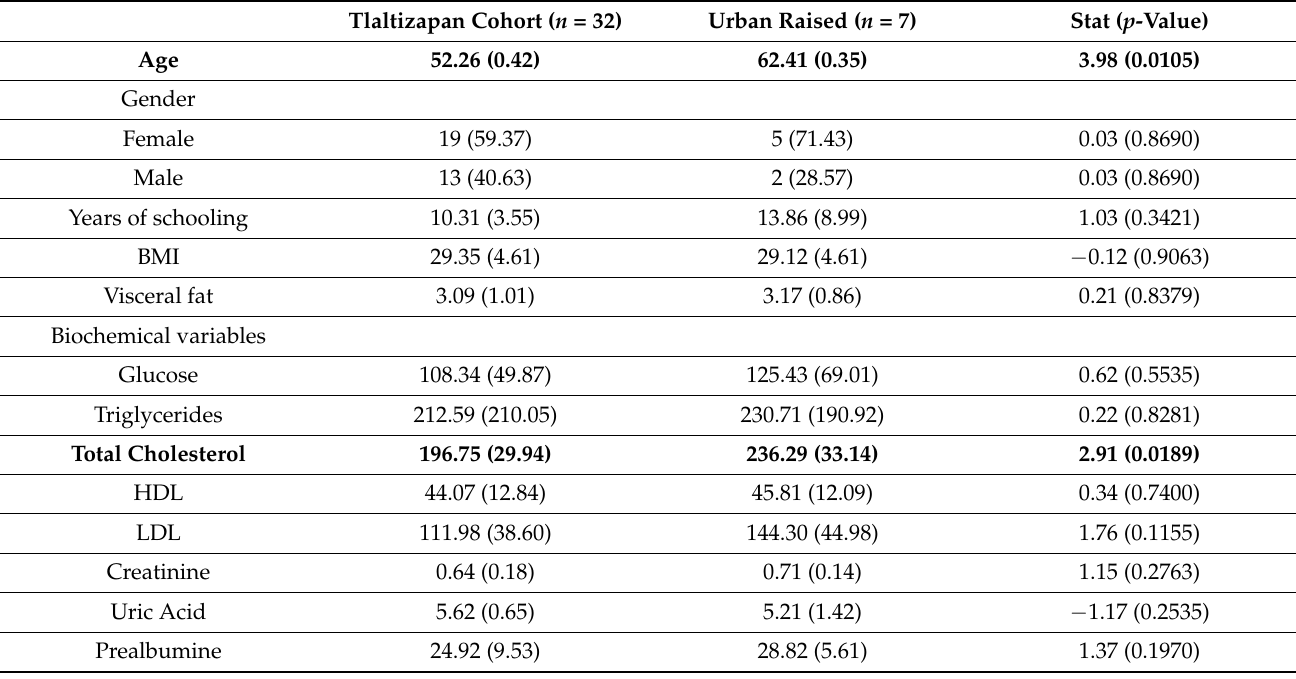
Table 1. Clinical, biochemical, and epigenetic